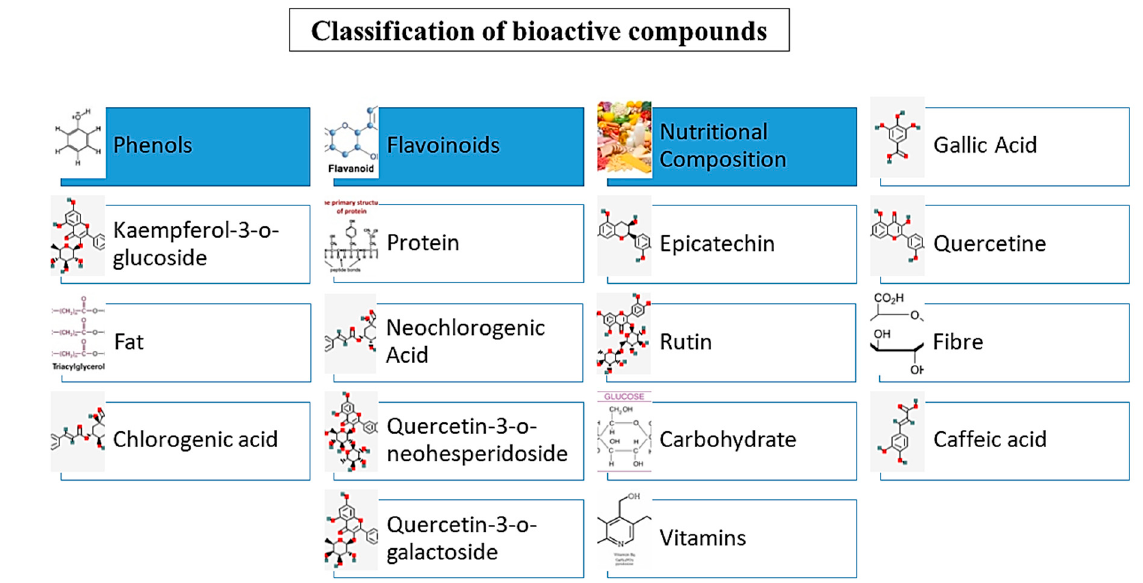
Figure 2. Chemical structures of different bioactive compounds present in the apricot kernel and their classification.